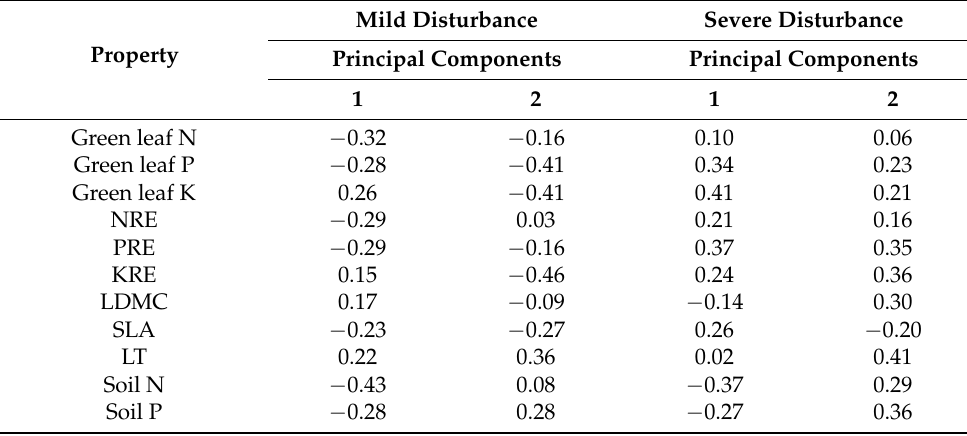
Table 3. Principal component analysis (PCA) analysis of green leaf nutrients, nutrient resorption efficiencies, and soil nutrients in the Phoebe bournei forest under different disturbances.